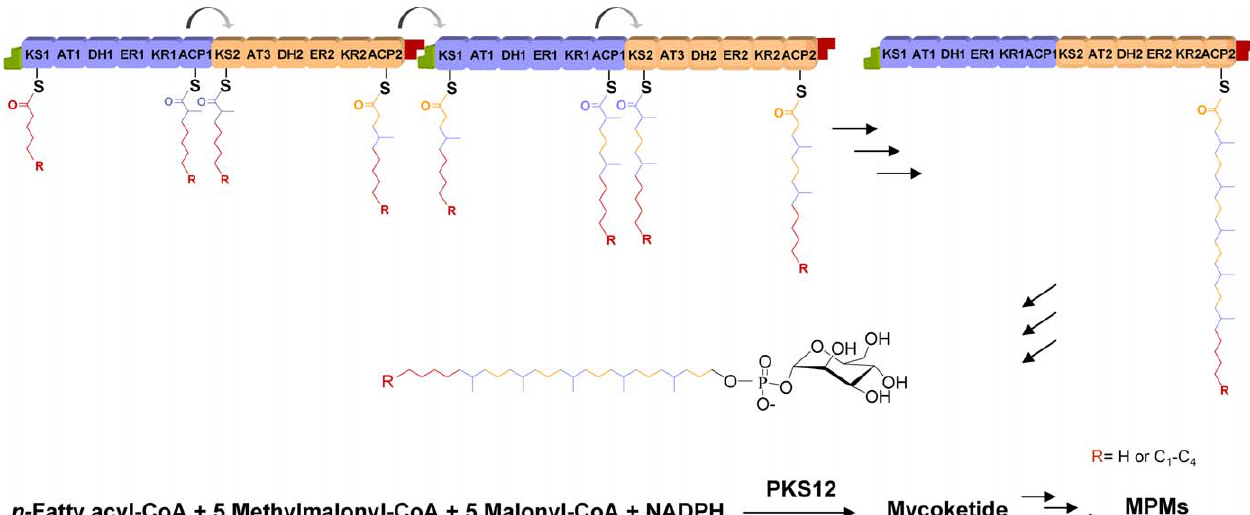
Figure 1. Involvement of PKS12 Protein in the Biosynthesis of Mannosyl- b -1-Phosphomycoketide A schematic representation of bimodular PKS12 protein from M. tuberculosis , which is required for the biosynthesis of mycoketide. The two modules of PKS12 are colored in blue (AT specificity for methylmalonyl CoA) and buff (AT specificity for malonyl CoA), and the N- and Cters are indicated in green and red, respectively. Individual domains are drawn as small boxes in the two modules. Mycoketide chain originates from repetitive condensations of methylmalonate and malonate units with medium-chain fatty acyl starters. This saturated chain is released from PKS12 by an unknown mechanism, which is followed by reduction, phosphorylation, and mannosylation to form MPM.